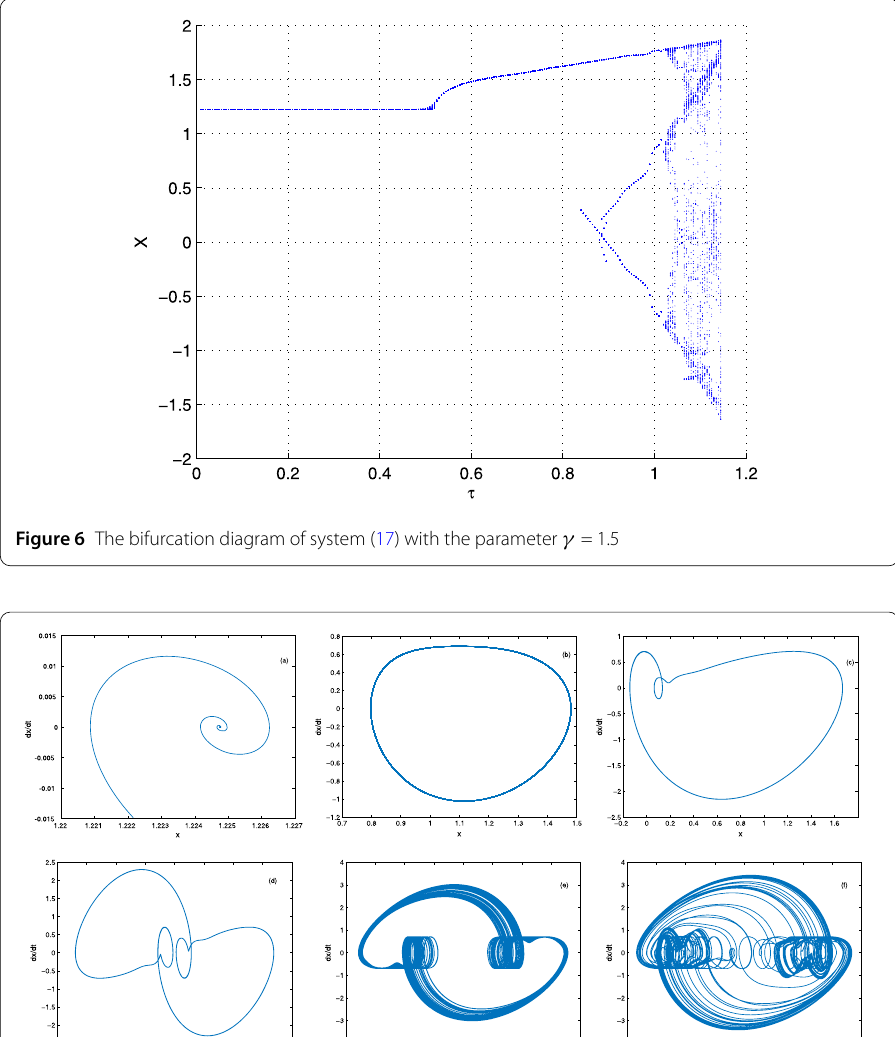
cycle appears at τ = 0.64. Further period doubling occurs at τ = 0.66 (period-2 to period- 4). Through a period doubling sequence, the system enters into the chaotic region at τ = 0.76. At last, the system becomes divergent at τ = 0.86. A phase plane representation in the representative x – dx / dt plane for different τ is shown in Fig. 9, which shows the following characteristics: stability ( τ = 0.25), period-1 ( τ = 0.45), period-2 ( τ = 0.65), period-4 ( τ = 0.68), and chaos ( τ = 0.77 and τ =